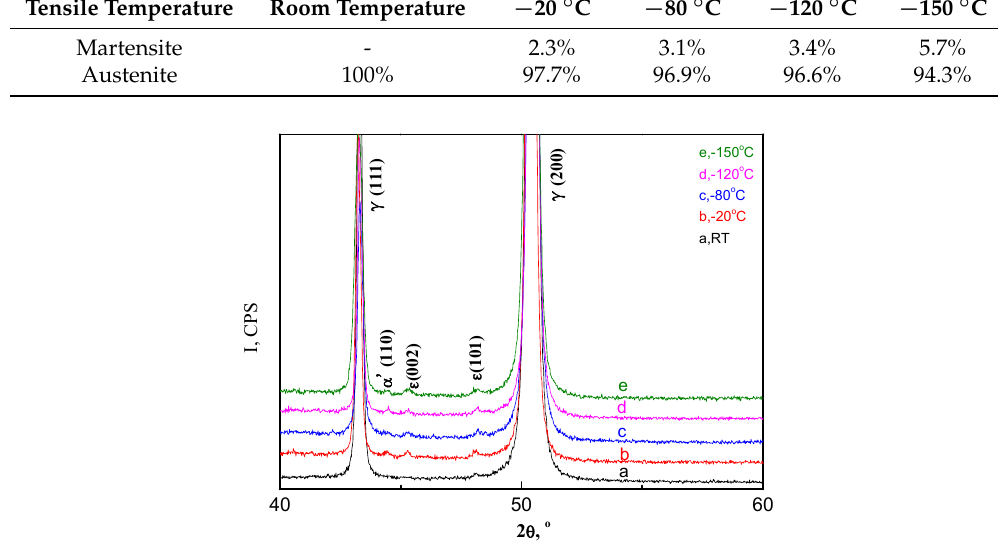
Figure 3. X-ray diffractograms of various test temperatures: RT, − 20 °C, − 80 °C, − 120 °C, and − 150 °C.